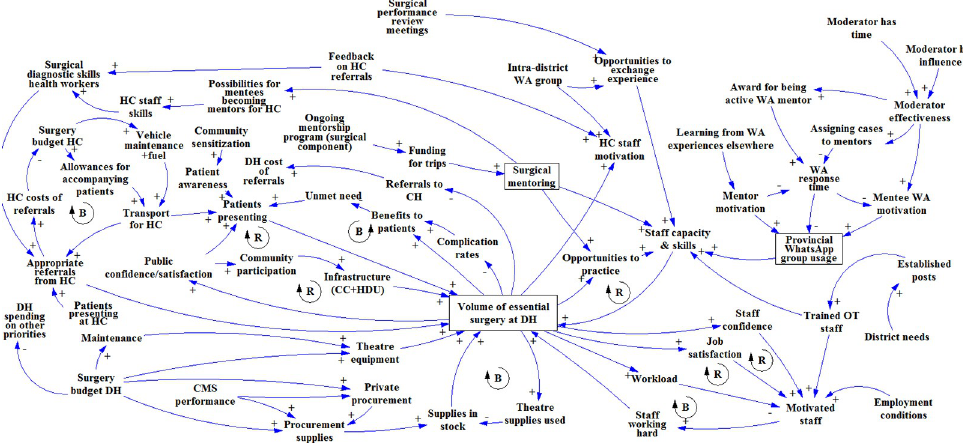
Fig 3. Causal loop diagram as it was built in the GMB workshop at Namwala district